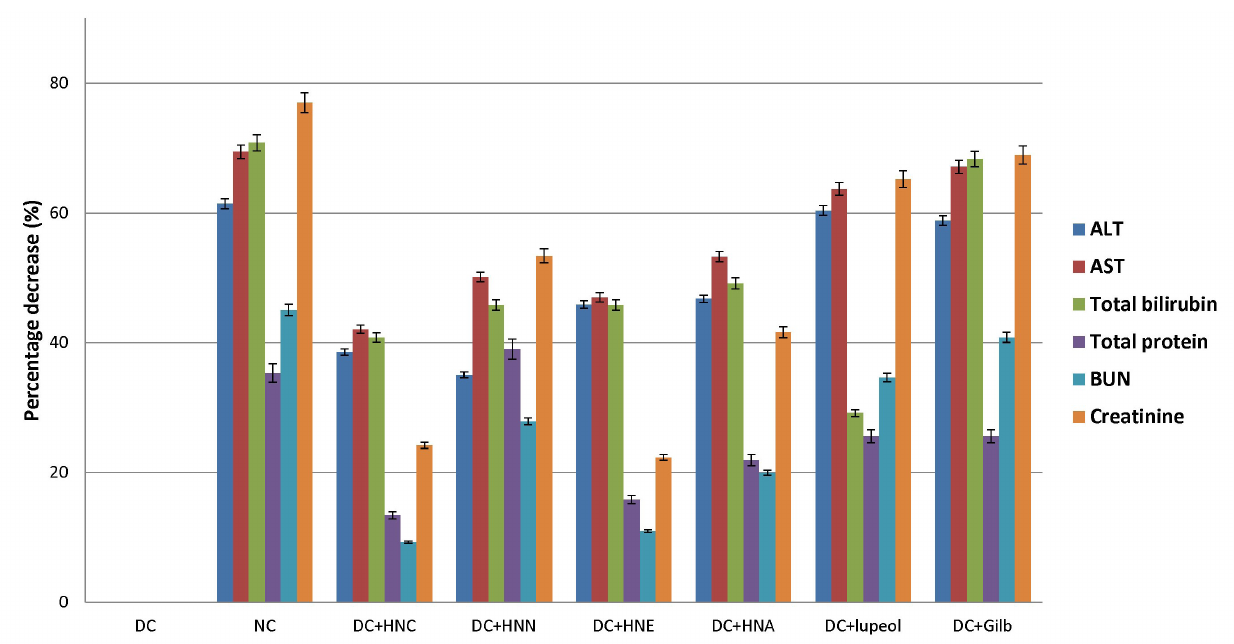
FIGURE 3 - Percentages of biochemical parameters after 15 days of treatment. Where “NC” is normal control, “DC” is diabetic control, “HNC” is H. nepalensis crude extract, “HNN” is H. nepalensis n-hexane fraction, “HNE” is H. nepalensis ethyl acetate fraction, “HNA” is H. nepalensis aqueous fraction and “Gilb” is glibenclamide served as positive